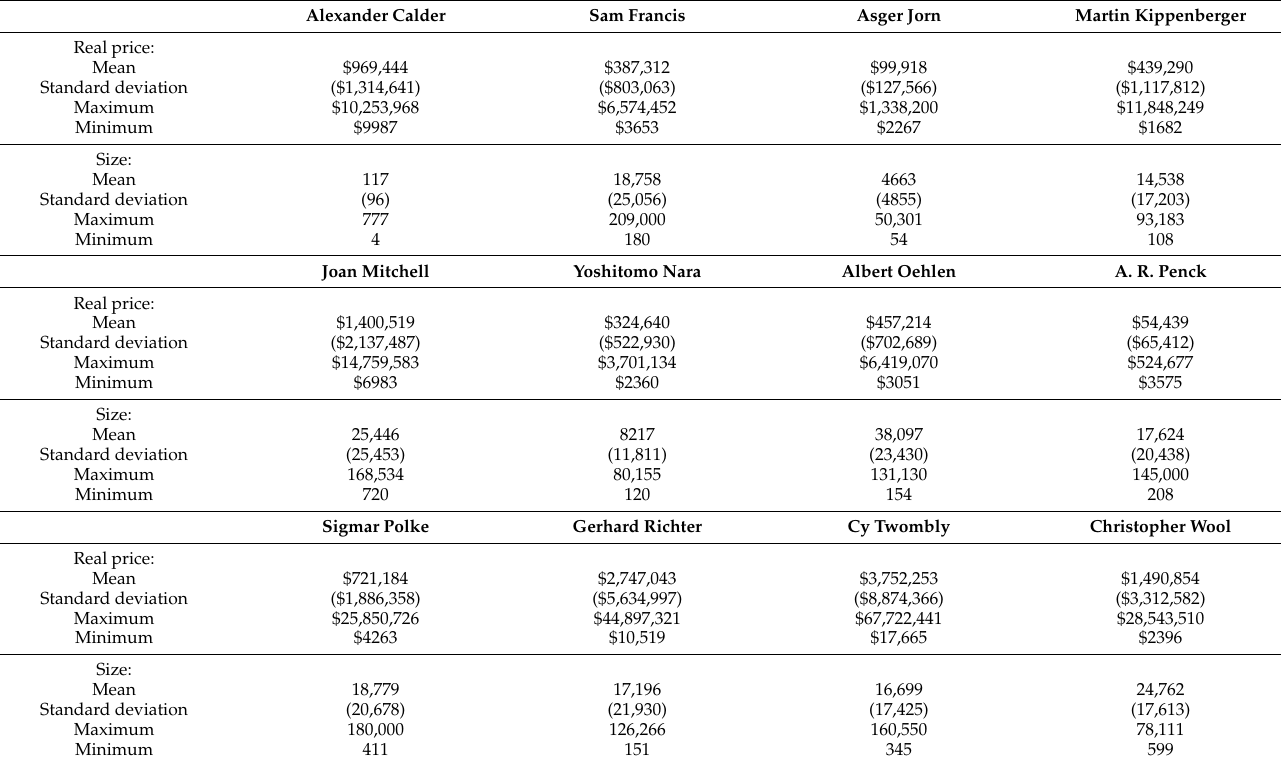
Table A3. Descriptive statistics for numerical variables 19